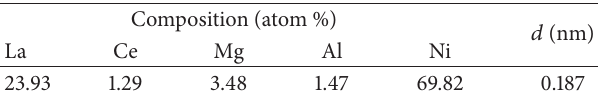
Table 2: Phase composition and interplanar distance for